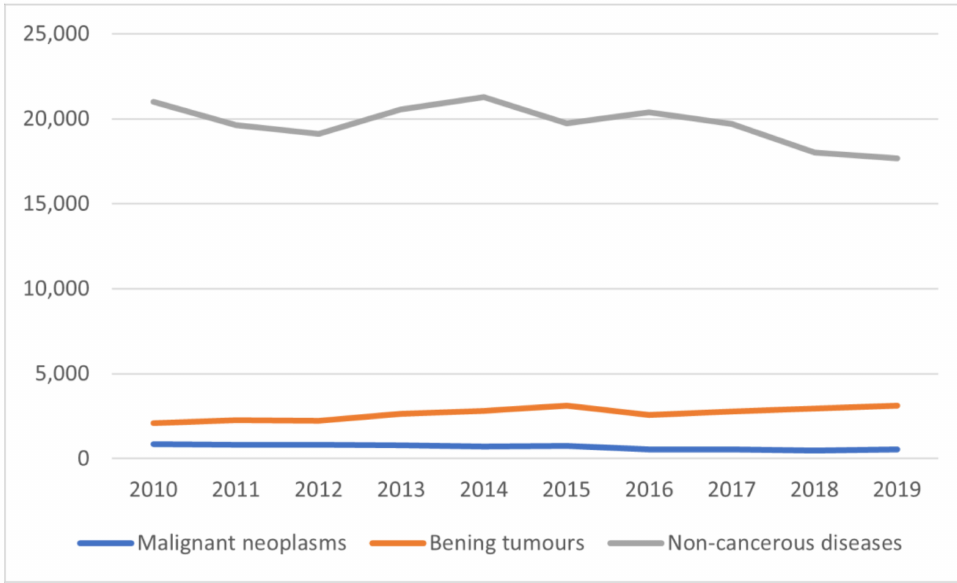
Figure 1. Overview of new salivary gland pathologies diagnosed in 2010–2019 in